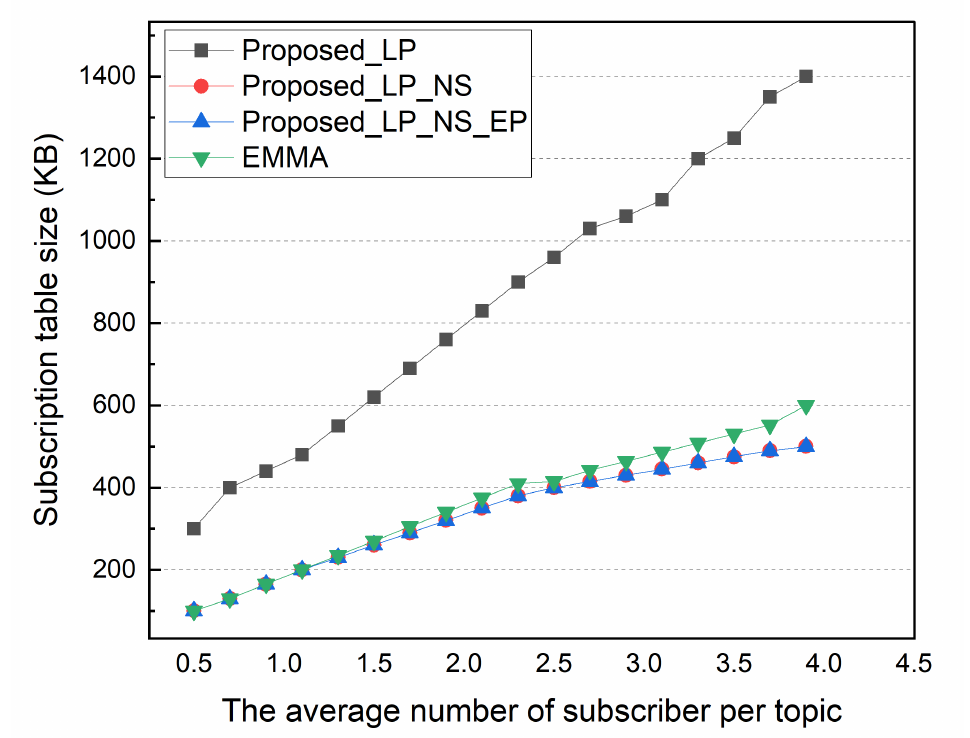
Figure 13. Subscription table size according to number of subscribers per